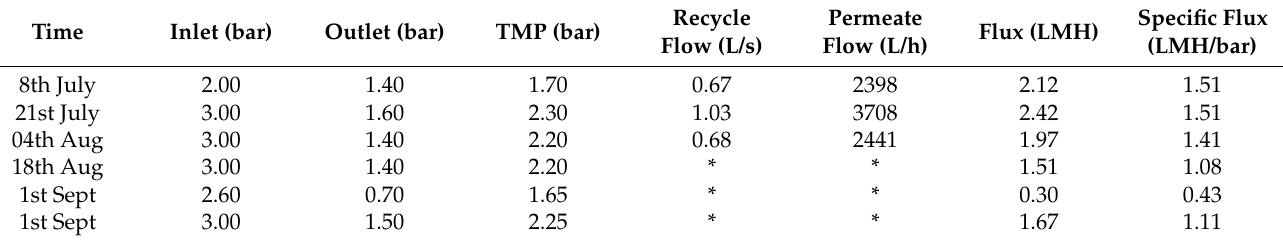
Table 11. RO membrane pilot-scale performance